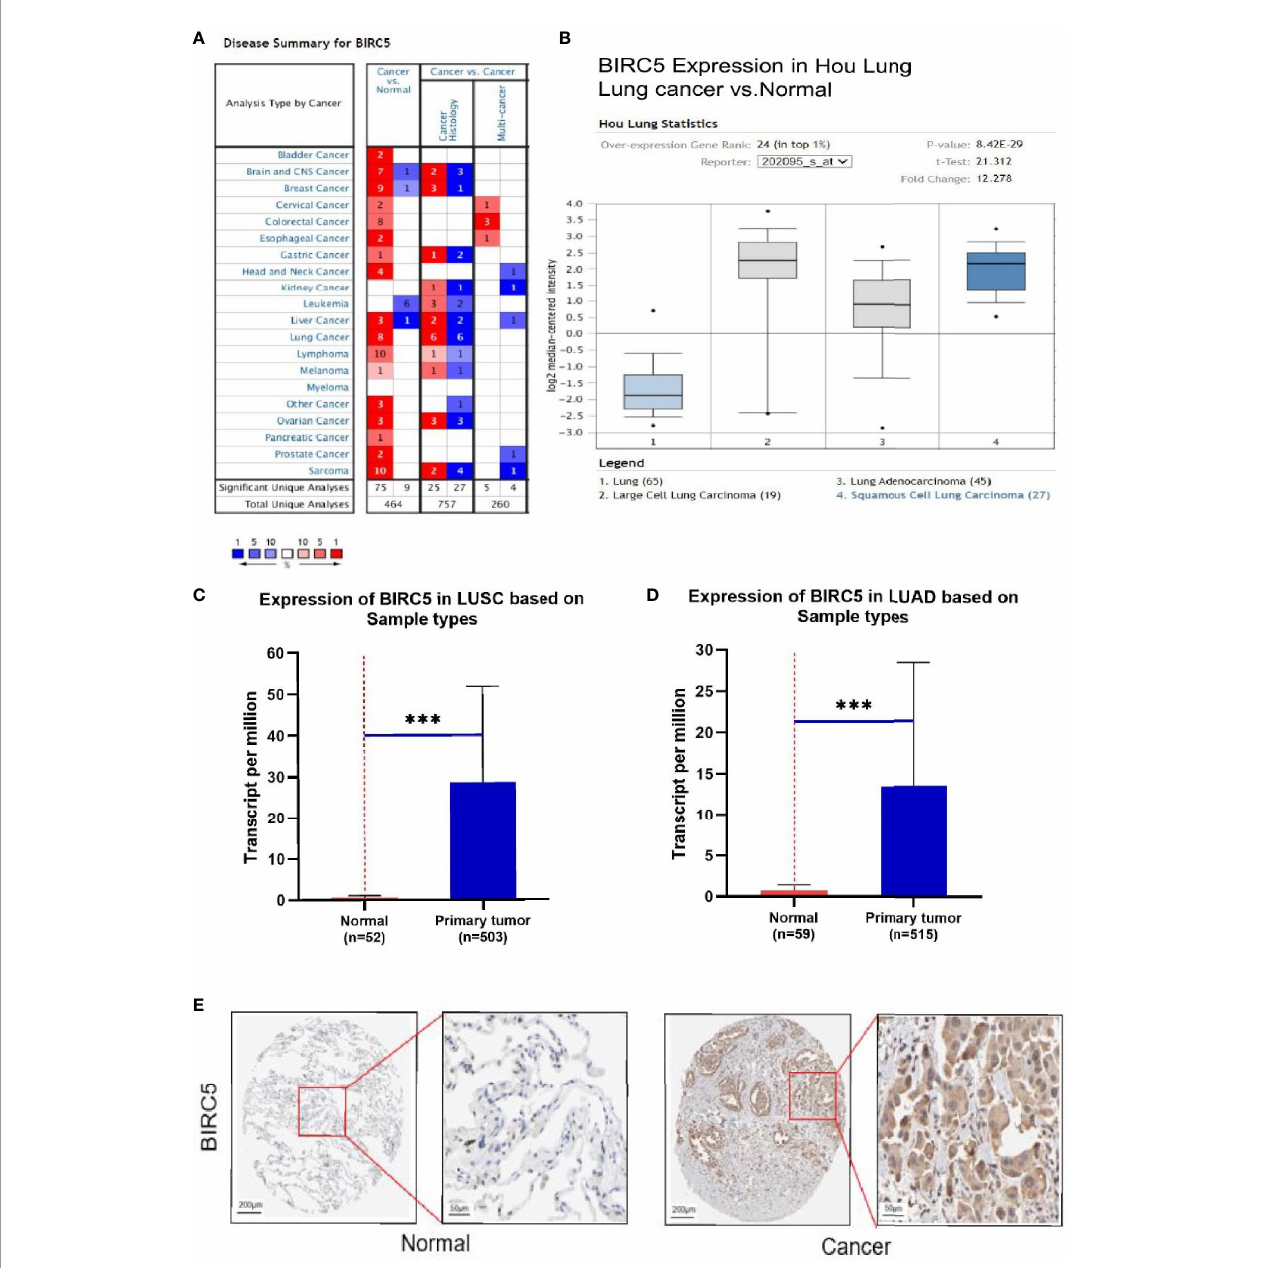
FIGURE 5 | The transcription levels of BIRC5 in lung cancer. (A) The expression level of BIRC5 in different cancers compared with that in normal tissues in the Oncomine database (P<0.0001, |FC|>2, and gene ranking of all). Compared with normal samples, BIRC5 mRNA was overexpressed in lung cancer samples in the Oncomine database (B) and UALCAN database (C, D) ***P < 0.001. (E) Immunohistochemical staining of BIRC5 protein expression in normal lung tissue and NSCLC tissue was obtained from the Human Protein Atlas online database (magni fi cation,